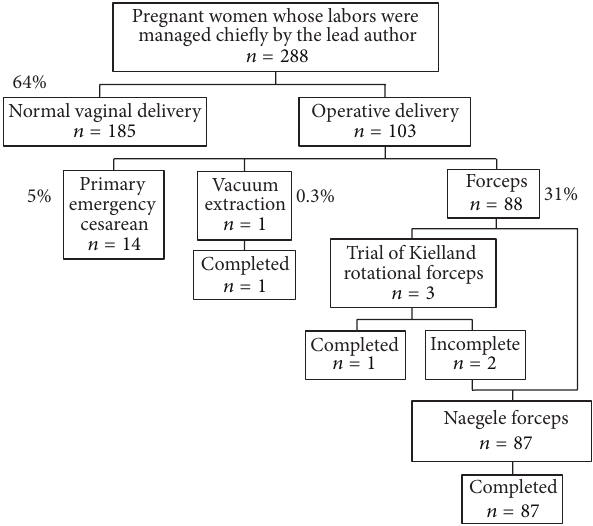
Figure 1: Mode of delivery of 288 term pregnant women with live singleton pregnancies and cephalic presentation whose labor and delivery were managed chiefly by the lead